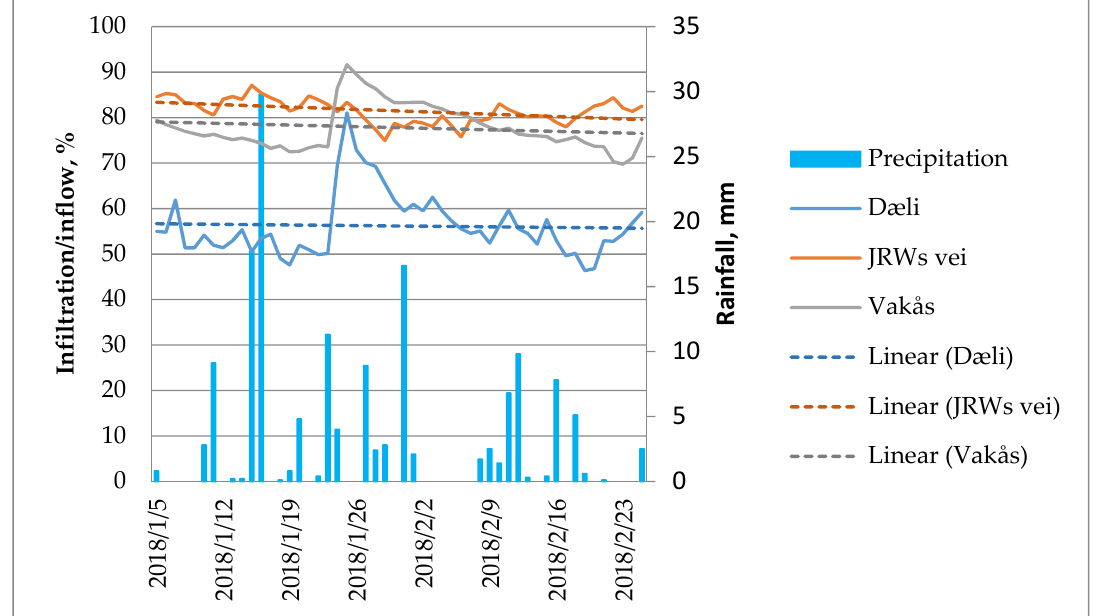
Figure 10. Calculated share of I/I-water in all surveyed points during rainfall, after the implementation of the measures.